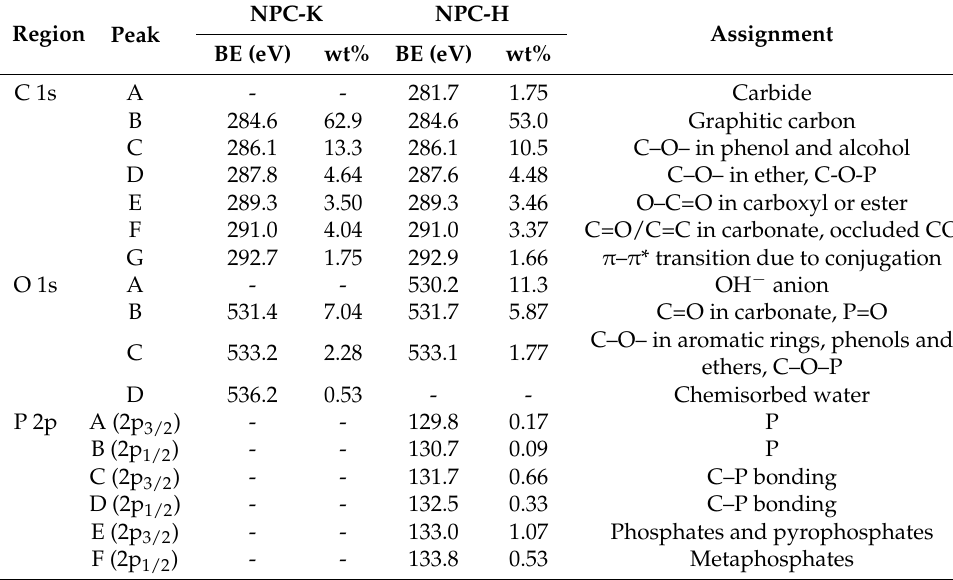
Table 3. Deconvolution of XPS spectra of NPC-K and NPC-H